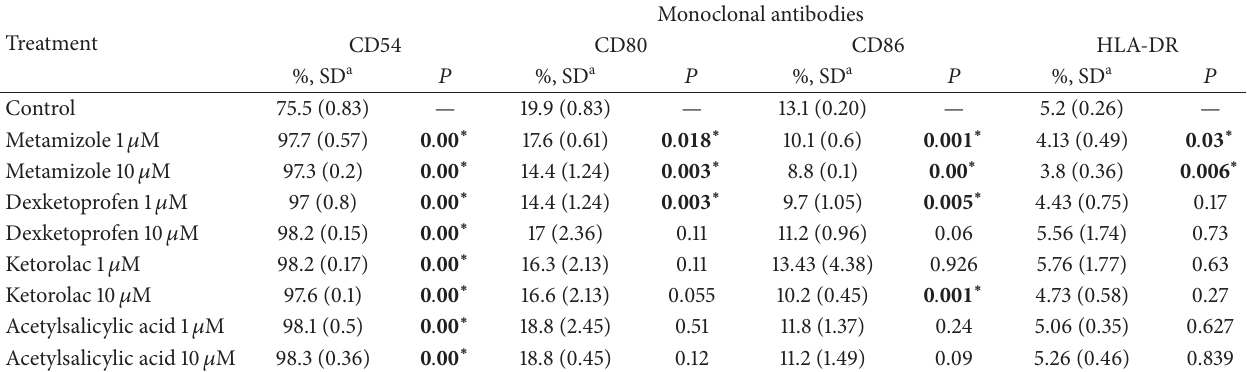
Table 2: Percentage of expression (by flow cytometry) of different antigens expressed in MG63 cell line after 24h of treatment with different anti-inflammatories, at doses of 1 and 10 𝜇 M.